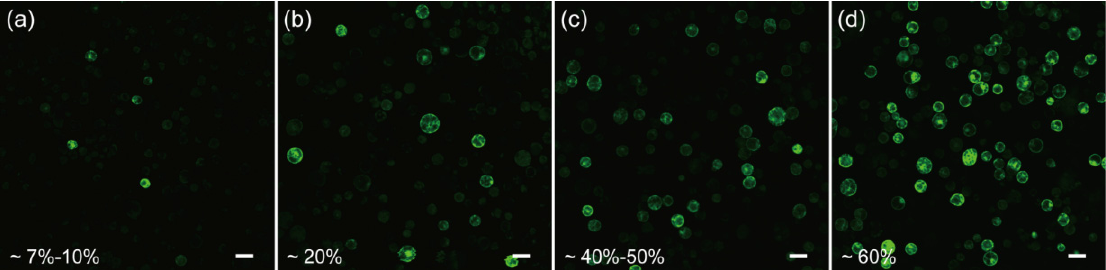
Figure 3. Optimization of the transient transformation system of C. pumila mesophyll protoplasts. ( a ) Under conventional PEG4000-mediated transformation, the efficiency was estimated around 7%–10%. ( b ) PEG4000-mediated heat shock transformation improved the efficiency to 20%. ( c ) The transformation efficiency was improved to 40–50% when incubated in W5 solutions. ( d ) On the basis of ( c ), the transformation efficiency was further enhanced to 60% with 0.2 M CaCl 2 in the PEG solu- tion. Scale bars, 50 μ m.